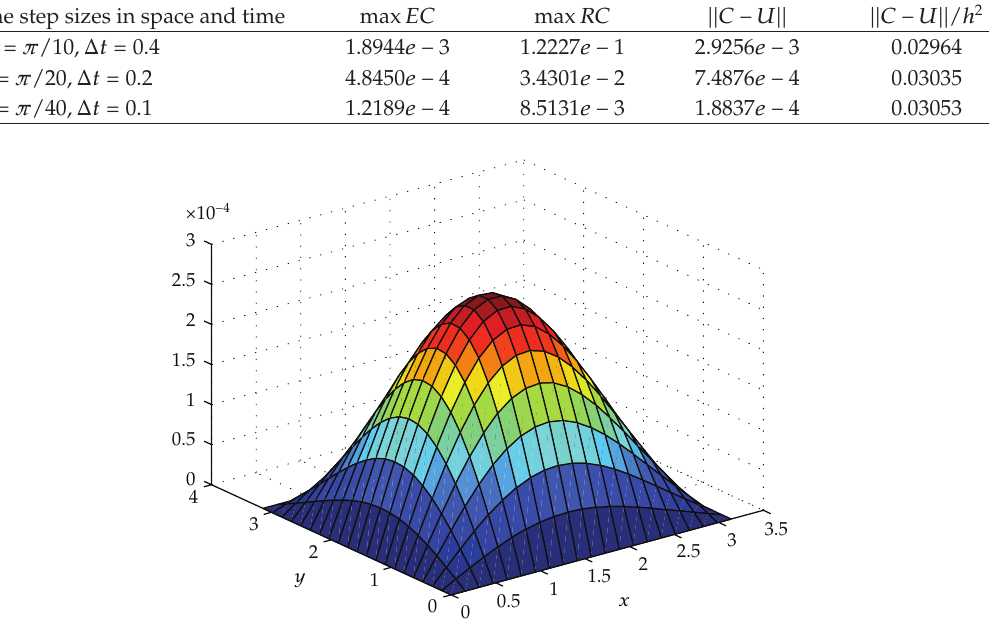
Figure 4: Absolute error when T (cid:9) 2, h (cid:9) π/ 20, and Δ t (cid:9) 0 .